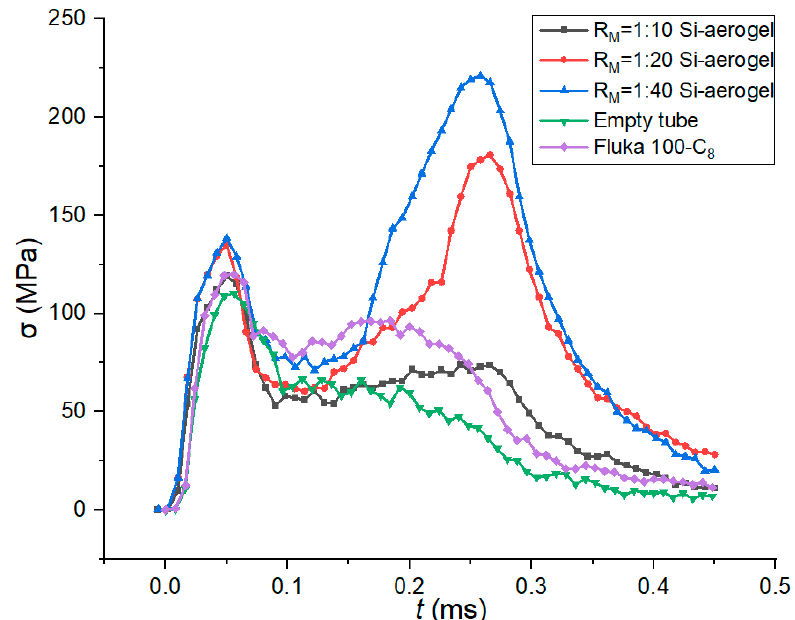
Figure 9. Stress–time curves with different solid/liquid ratios.